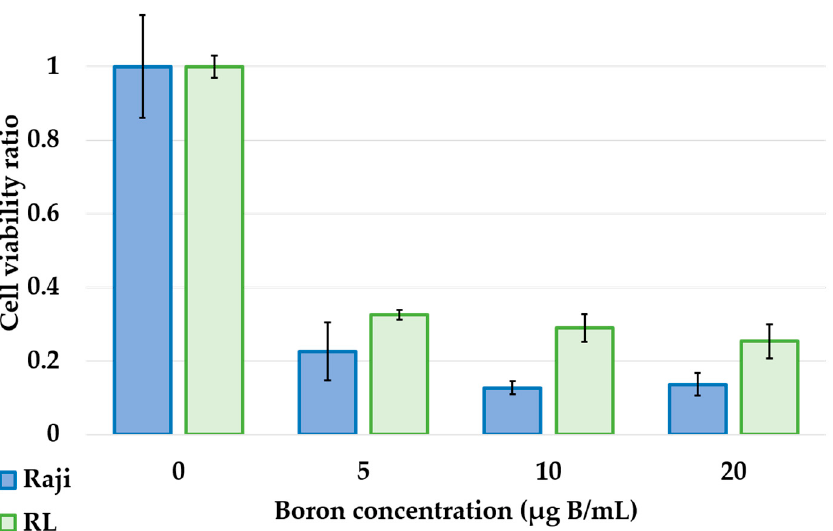
Figure 3. Relationship between boron concentration and cell viability ratio after neutron irradiation. Cell viability of lymphoma cells after exposure to BPA at concentrations of 5, 10, and 20 µ g B/mL for 3 h followed by irradiation with 1 MW neutrons for 30 min and incubation for 96 h. Blue is Raji lymphoma cells, and green is RL lymphoma cells. In Raji lymphoma cells. BNCT significantly reduced the cell viability of lymphoma cells ( p <